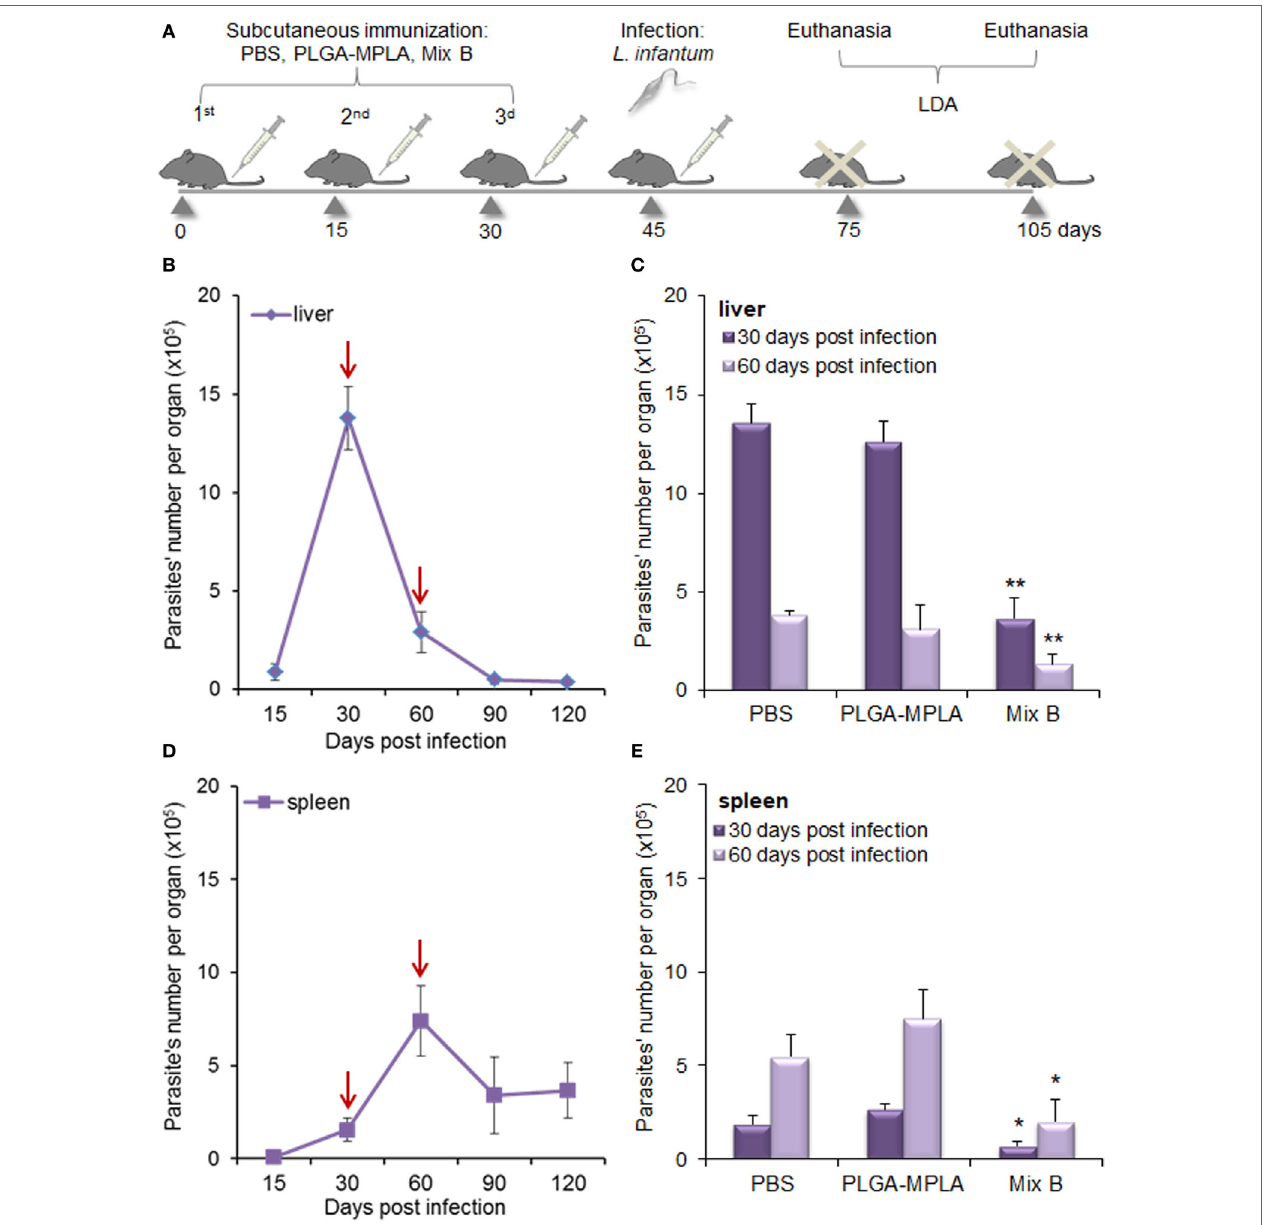
FigUre 11 | Immunization with the mix of peptide-based poly(lactic- co -glycolic) acid (PLGA) nanoformulations with monophosphoryl lipid A (MPLA) incorporation conferred significant protection against Leishmania infantum infection in HLA A2.1 transgenic mice. (a) Immunization and infection scheme. Mice were subcutaneously immunized with the mix of PLGA-chCPAp-MPLA, PLGA-chH1p-MPLA, and PLGA-KMP-11p-MPLA nanoformulations (mix B), PLGA-MPLA nanoformulations or only PBS. Two weeks after the last boosting dose, immunized and non-immunized mice were infected intravenously with 2 × 10 7 L. infantum promastigotes and parasite burden was evaluated 1 and 2 months post-infection with a limiting dilution assay. (B,D) Time course of infection in liver (B) and spleen (D) of HLA A2.1 transgenic mice infected with L. infantum promastigotes. Red arrows indicate the time points selected for the evaluation of immunization’s protective effect. (c,e) Parasite burden in the liver (c) and the spleen (e) of immunized and non-immunized mice 1 and 2 months post-infection with L. infantum . Results are presented as the mean ± SD of five individual mice per group and significant differences between the parasite burden of immunized with mix B mice and the parasite burden of non-immunized mice are indicated by * p < 0.05 or ** p <